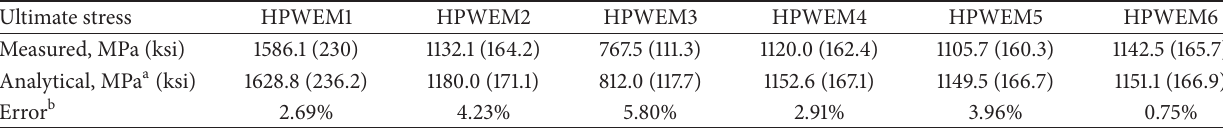
Table 5: The ultimate stress of the unbonded strands.